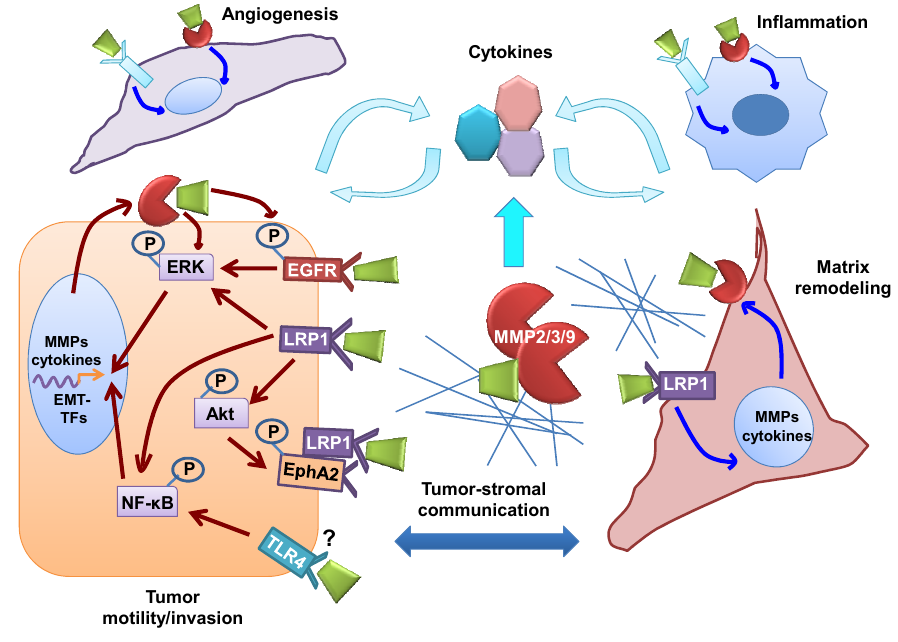
Figure 2. Role of eHsp90 in cancer. (Refer to cell type key in Figure 2). Summary of eHsp90 functions compiled from published reports in cancer epithelial and glioma cells (depicted by red arrows). eHsp90 interacts with a number of receptors (not directly confirmed for TLR4) to initiate signaling events converging upon AKT, ERK and NF- κ B to facilitate cell motility. eHsp90-mediated activation of ERK and NF- κ B promote epithelial to mesenchymal transition (EMT) activation in prostate and colon cancer, respectively. EMT activation collaborates with eHsp90-dependent signaling to further stimulate expression of MMPs and cytokines. Surface eHsp90 may also activate ERK through a variety of signaling intermediates. Surface eHsp90 signaling and MMP activation also elicits a CAF-like stromal reaction and promotes neoangiogenesis. CAF-like cells contribute to the inflammatory milieu, to the desmosplastic stroma, and to the angiogenic response. The earliest reports identified surface Hsp90 on inflammatory cells, thereby also implicating eHsp90 as a direct modulator of immune components in the cancer microenvironment. Finally, eHsp90 has been shown to interact directly with matrix components, indicating an accessory role in ECM remodeling. These collective events create an intricate web of cancer-stromal interactions that have the potential to create robust feed-forward networks that drive cancer